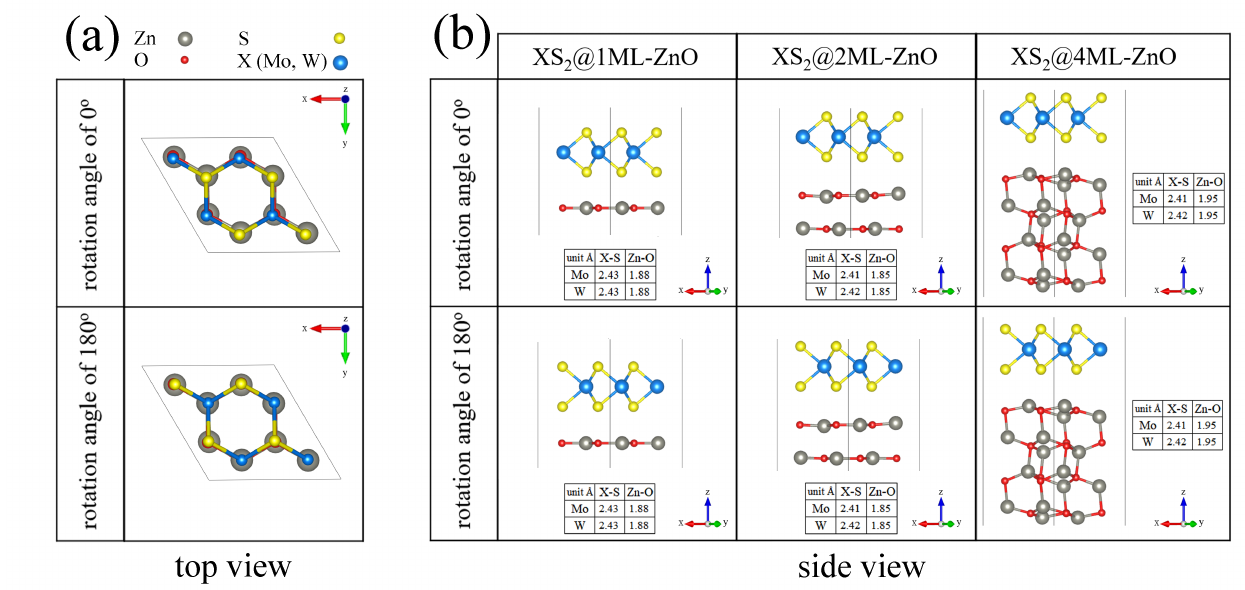
Figure 1. Top view ( a ) and side view ( b ) of the models of MoS 2 @ZnO and WS 2 @ZnO nanocomposites with graphene-like 1ML-ZnO and 2ML-ZnO substrates, as well as the wurtzite-like 4ML-ZnO substrate. Structures with 0 ◦ and 180 ◦ rotation angles are shown. Inset tables list the average bond lengths in